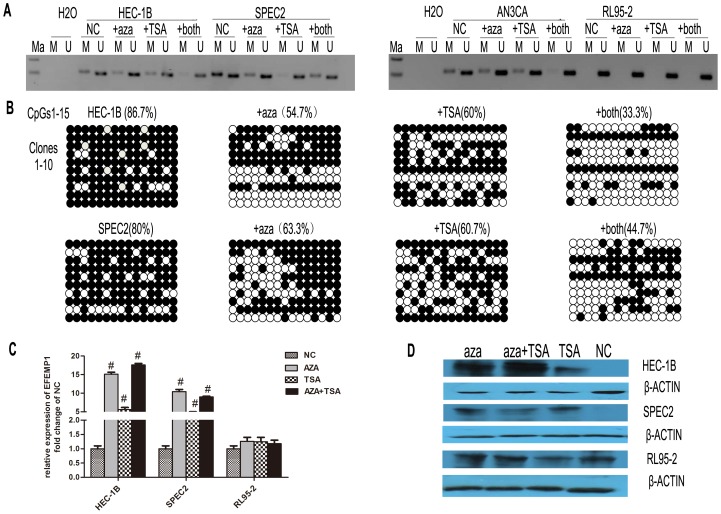
The effect of 5-aza-dC and TSA on EFEMP1 expression.A: Endometrial carcinoma cell-lines HEC-1B, AN3CA and SPEC2, shown to be methylated in the DNA promoter regain of EFEMP1, and RL95-2 shown to be unmethylated. Cells were treated with 5-aza-dC (10 µM) and/or TSA (200 ng/ml) for 96 h, and the methylation status of EFEMP1 was assessed by MSP. B: Bisulfite genomic sequencing detected endogenous levels of methylation before and after treatment with 5-aza-dC (10 µM) and/or TSA (200 ng/ml). Columns indicate clones 1–10; horizontal lines show the analysis of CpG dinucleotides 1–15. Black dots symbolize methylated CpGs, and white dots symbolize unmethylated CpGs. C: Showing qRT-PCR analysis and evaluation of EFEMP1 mRNA expression before and after treatment with 5-aza-dC and/or TSA. Data representative of three independent experiments are shown. # P<0.05. D: Western immunoblot showing changes in EFEMP1 protein expression. Protein samples were extracted from cells that were treated with 5-aza-dC and/or TSA.